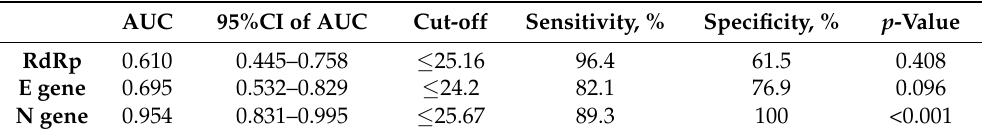
Table 4. Criterion values and coordinates of the receiver operating characteristic curves for positive Ag-RDT test with Ct levels of RT-PCR test.